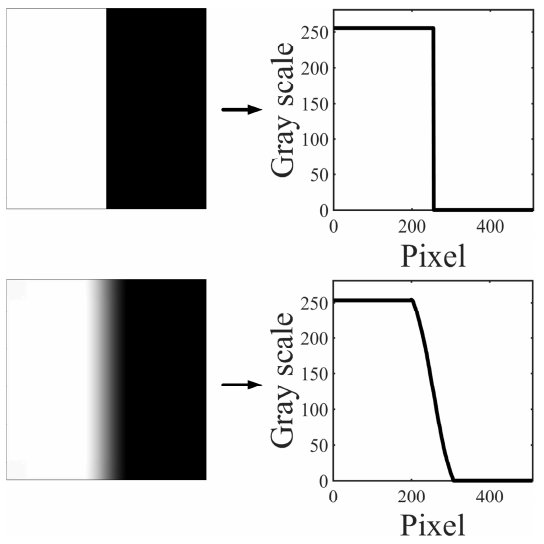
Figure 1. Step edge image and its corresponding grayscale change curve of pixels on a row.